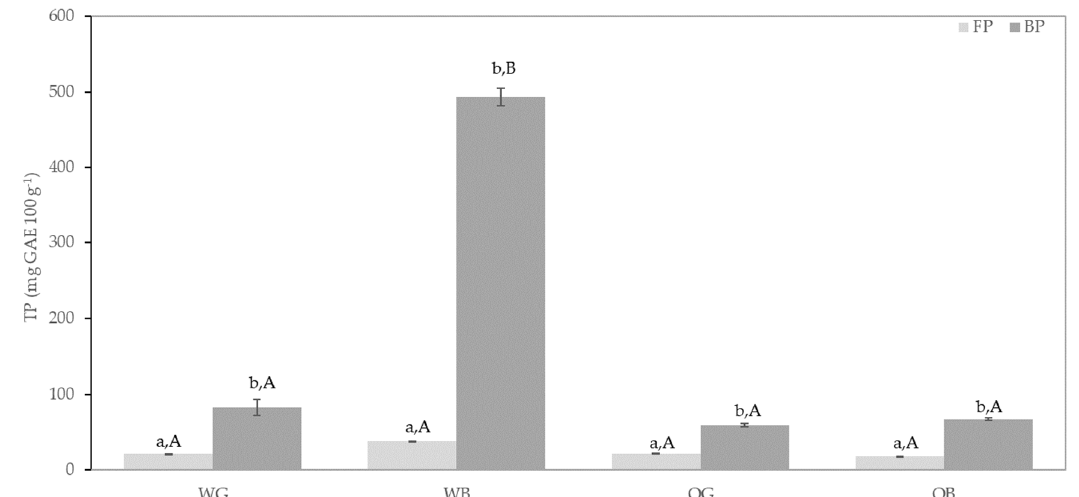
Figure 3. Total Phenolic compounds (TP) content for free phenolic fraction (FP) and insoluble phenolic fraction (BP) of wheat grain (WG), oat grain (OG), and their bran, wheat bran (WB) and oat bran (OB). Results were expressed mg GAE/100 g of dry sample. Different lowercase letters indicate significant differences ( p < 0.05) in a given sample (WG, WB, OG, or OB) between fractions (FP vs. BP) and capital letters indicate significant differences ( p < 0.05) in a given fraction (FP or BP) among samples (WG, WB, OG, and OB). Table 2. HPLC-DAD-ESI/MS analysis of free (FP) and bound (BP) phenolic fractions of wheat grain (WG), oat grain (OG), wheat bran (WB) and oat bran (OB). Results were expressed in ( µ g g − 1